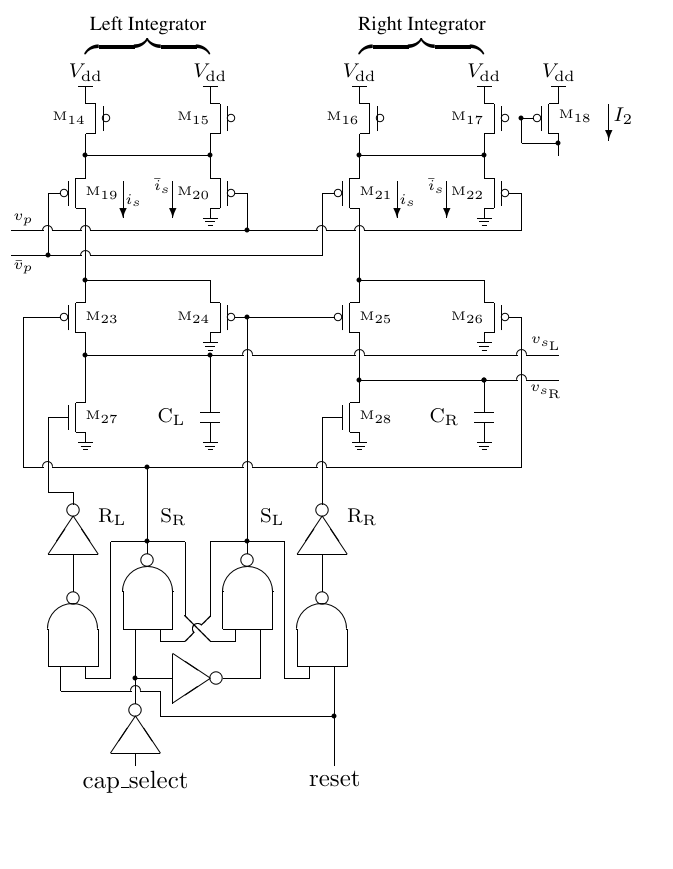
Figure 7. Integrator circuit